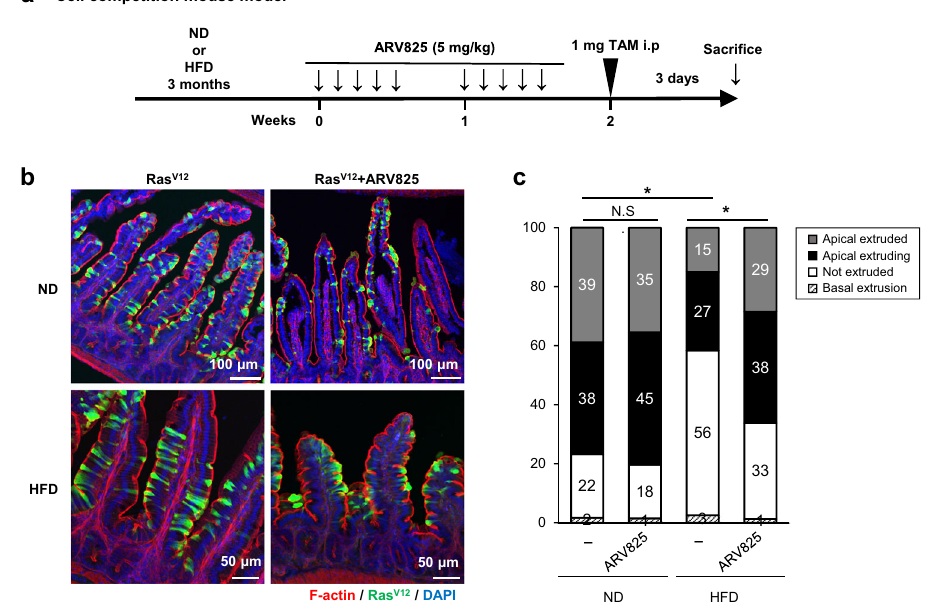
Fig. 5 ARV825 improves apical extrusion of the Ras V12 -transformed cells in the small intestine of the HFD-fed cell competition model in vivo. a Timeline of the experimental procedure. Cell competition model mice, LSL-Ras V12 -IRES-eGFP and villin-Cre- ERT mice, in whom Ras V12 expression is induced by tamoxifen treatment (TAM) in a Cre-dependent fashion and traced using simultaneous expression of eGFP 18, 27 , were fed HFD for 3 months. The black arrow indicates an intraperitoneal treatment with 5 mg/kg ARV825. b , c Immuno fl uorescence images ( b ) and quanti fi cation analysis ( c ) of Ras V12 cells in the epithelium of the small intestine. Phalloidin (F-actin, red) and Ras V12 signals (green) were detected in the small intestine, and DNA was stained using DAPI (blue) (N-Ras V12 , n = 3 (ND); N-Ras V12 + ARV825, n = 3 (ND); N-Ras V12 , n = 3 (HFD); N-Ras V12 + ARV825, n = 3 (HFD)). Scale